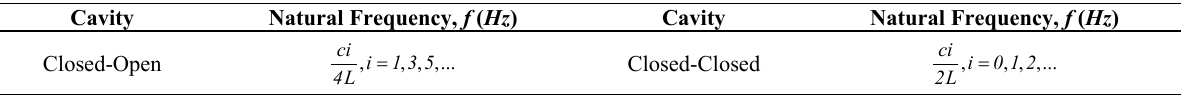
ci = Closed-Closed , , ,... i 1 3 5 4L